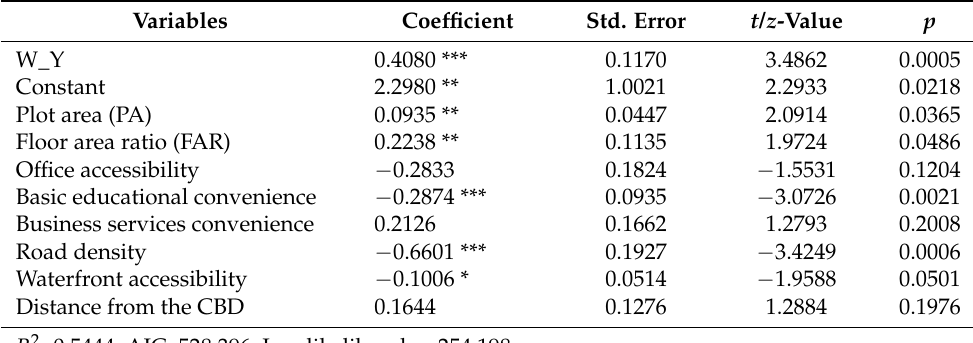
Table 4. SLM model